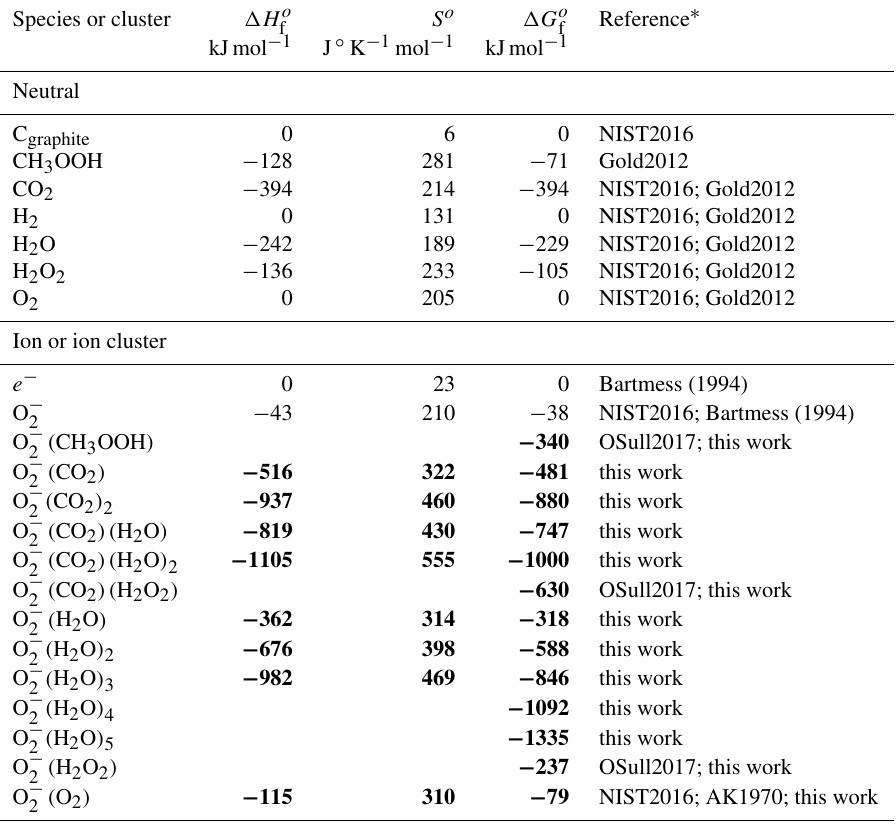
Table A5. Enthalpy of formation, entropy and Gibb’s formation energy for neutral, ion and ion clusters in the O − hydroperoxide system. Note: bold font indicates value derived in this work using published formation and reaction enthalpy, entropy and Gibb’s